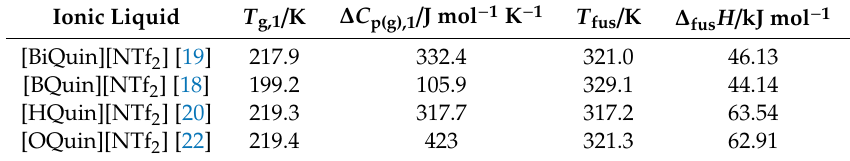
Table 8. Thermal properties of the investigated ionic liquids: glass transition temperature ( T g,1 ) and heat capacity change at glass transition temperature ( ∆ C p(g),1 ), melting temperature ( T fus ), and enthalpy ( ∆ fus H ) a